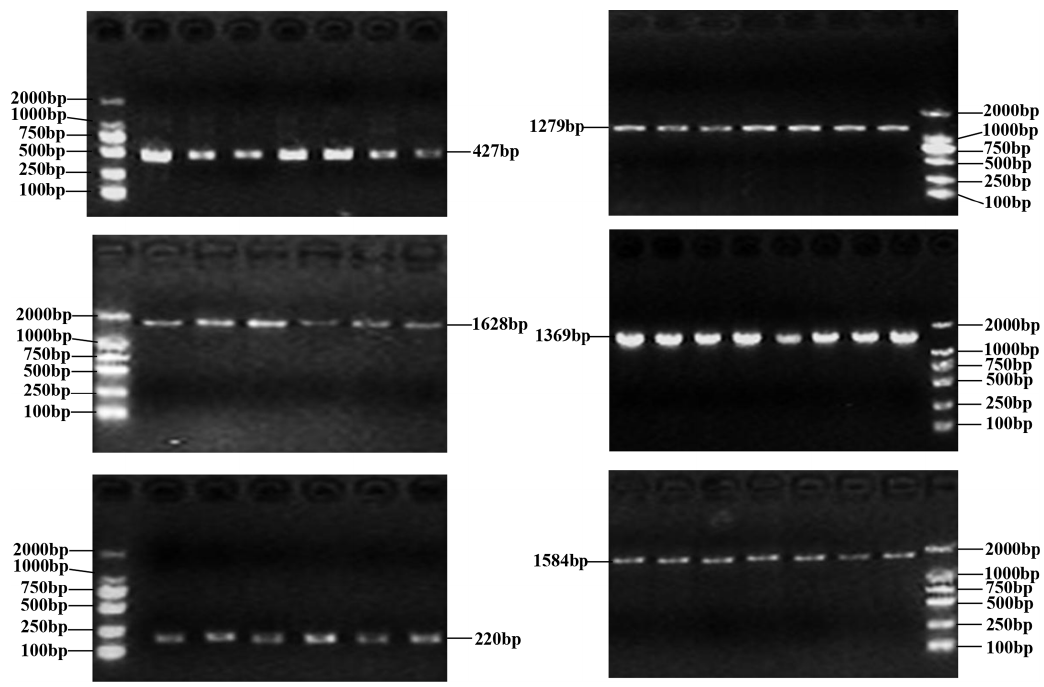
Figure 1. Six PCR-amplified fragments of buffalo CSN1S2 detected by agarose gel electrophoresis. Table 2. Polymorphic loci and their allelic and genotypic frequencies in two types of buffalo. Population SNP Genotype Allele P value ∗ frequency frequency River